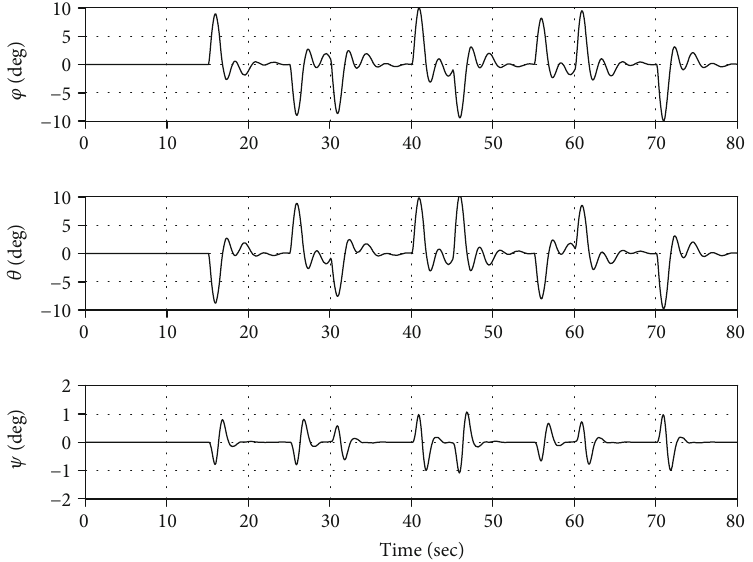
Figure 11: Time history of Euler angles.